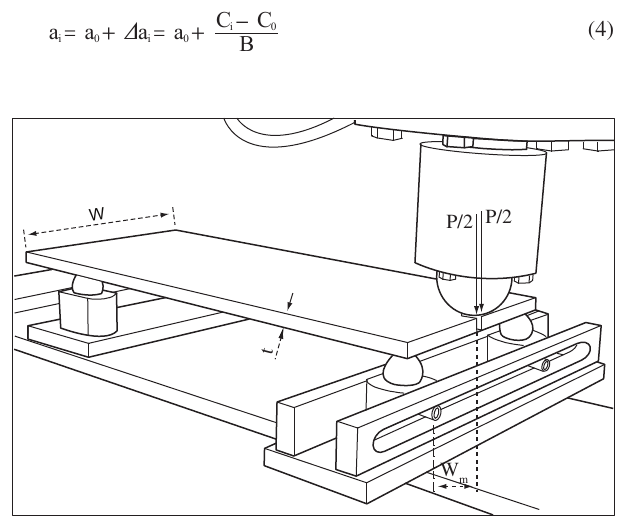
Figure 1. Double-torsion test arrangement showing devices fabricated to carry out the test and some important